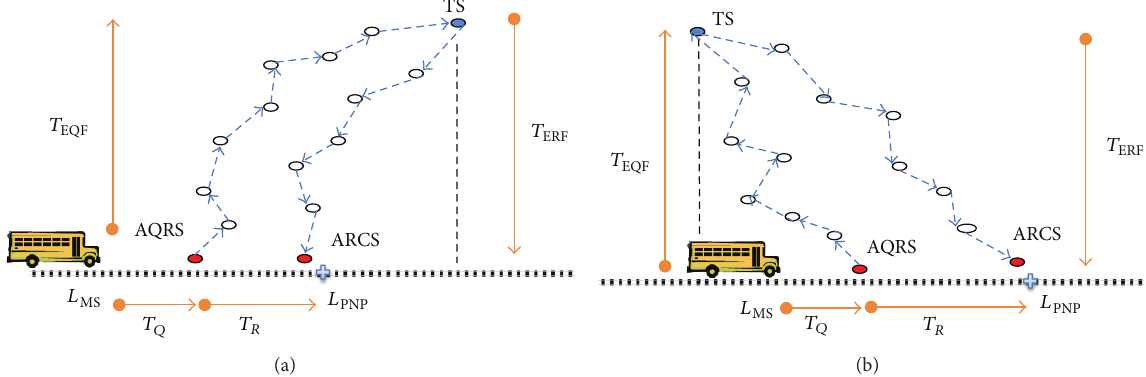
Figure 5: Most Energy Consuming Schedule when MS moves in the direction of TS (a) and when it moves in the other direction (b).